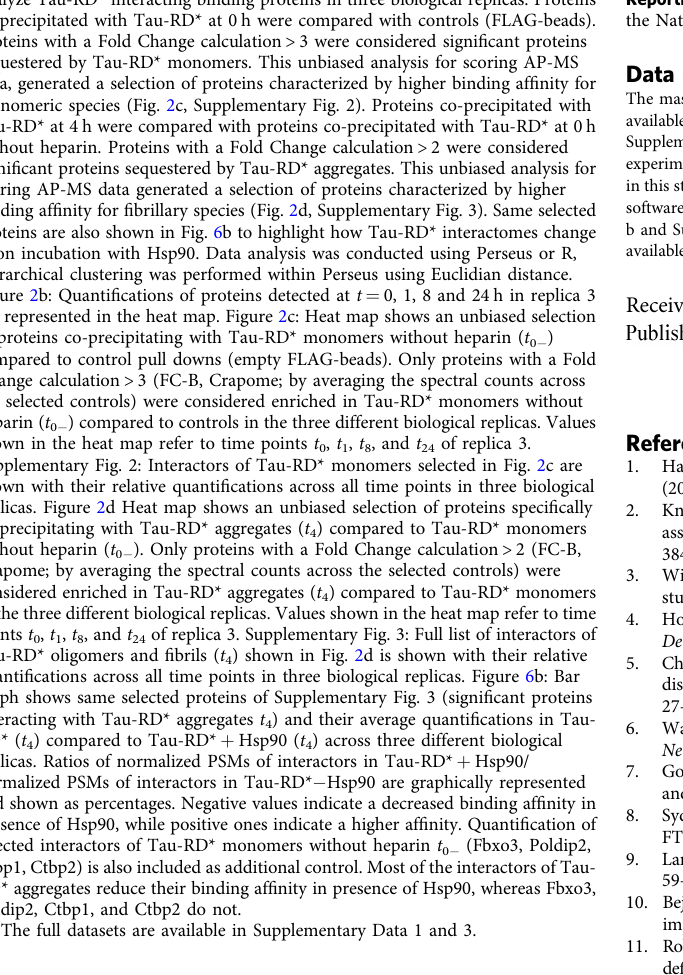
replicas. Supplementary Fig. 5: Full list of interactors of Tau-RD* oligomers and fi brils ( t 4 ) shown in Supplementary Fig. 3 is shown with their relative intensity- based quanti fi cations across all time points in three biological replicas. Supplementary Fig. 8: Bar graph shows selected proteins of Supplementary Fig. 5 (signi fi cant proteins interacting with Tau-RD* aggregates) and their average quanti fi cations in Tau-RD* ( t 4 ) compared to Tau-RD* + Hsp90 (t 4 ) across three different biological replicas. Differences between log2_normalized intensities of interactors in Tau-RD* + Hsp90 and log2_normalized intensities of interactors in Tau-RD* − Hsp90 are graphically represented. Negative values indicate a decreased binding af fi nity in presence of Hsp90, while positive ones indicate a higher af fi nity. Quanti fi cation of selected interactors of Tau-RD* monomers without heparin t 0 − (Fbxo3, Poldip2, Ctbp1, Ctbp2) is also included as additional control. Almost all the interactors of Tau-RD* aggregates reduce their binding af fi nity in presence of Hsp90 whereas Fbxo3, Poldip2, Ctbp1, and Ctbp2 do not. The full datasets are available in Supplementary Data 2 and